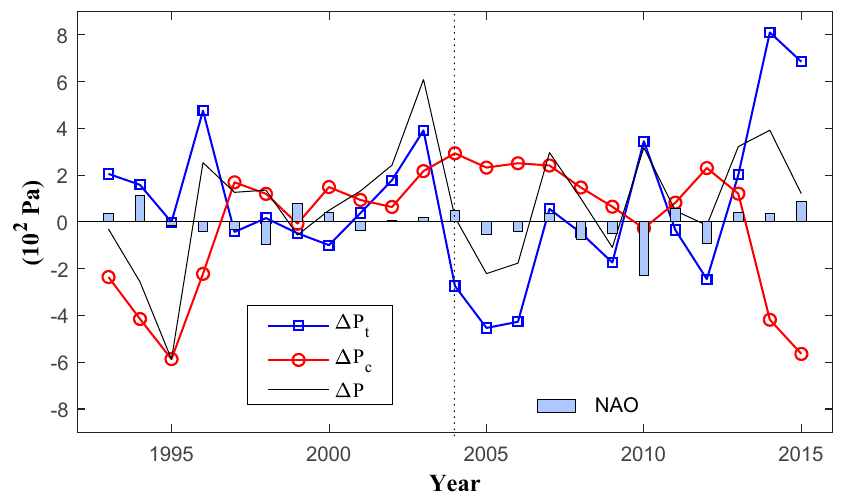
Figure 6. The variations of annual mean of ∆ P trop , ∆ P clin , and ∆ P. The positions of the selected grid points to calculate pressure difference on both sides of the GSR are shown in Figure 1.